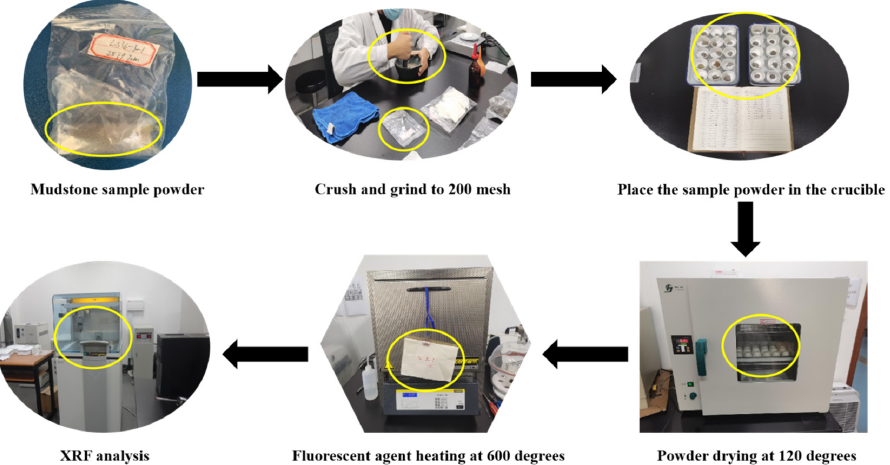
Figure 6. The flow chart of the main test analysis methods.